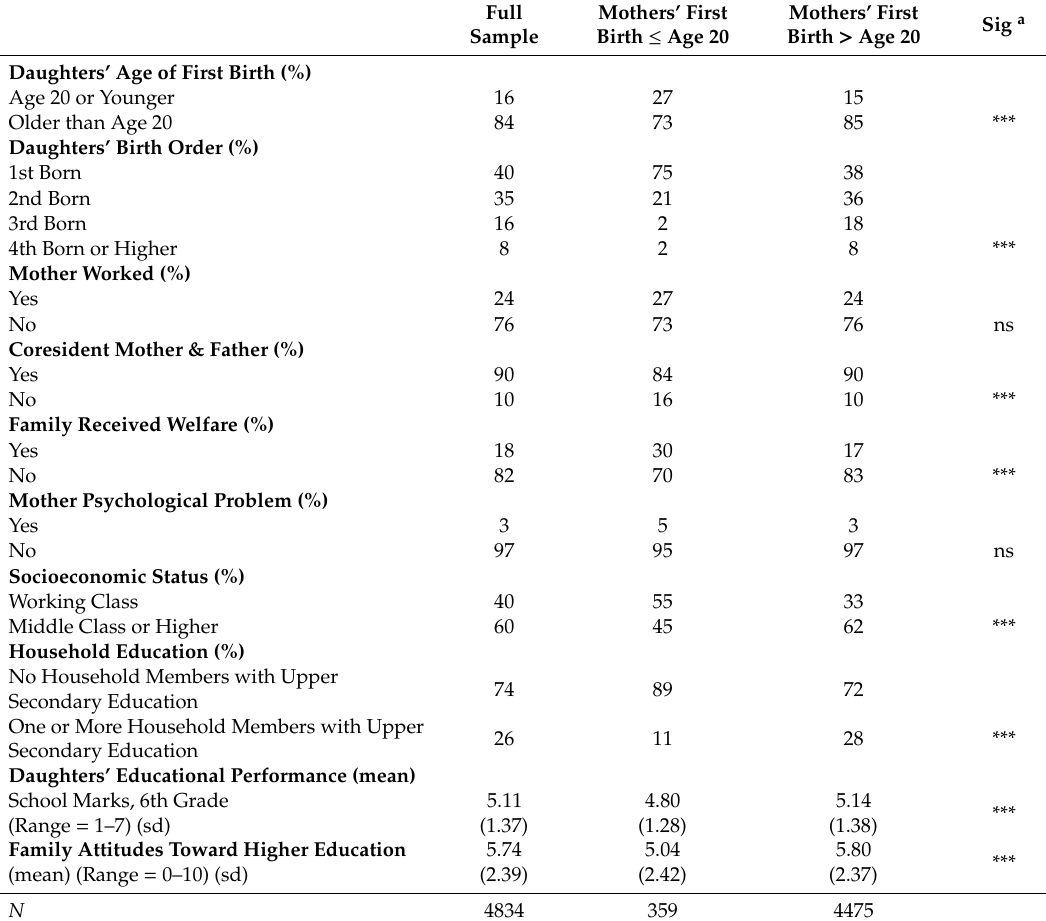
Table 1. Descriptive Statistics for the Full Sample and Shown Separately by Mothers’ Timing of First